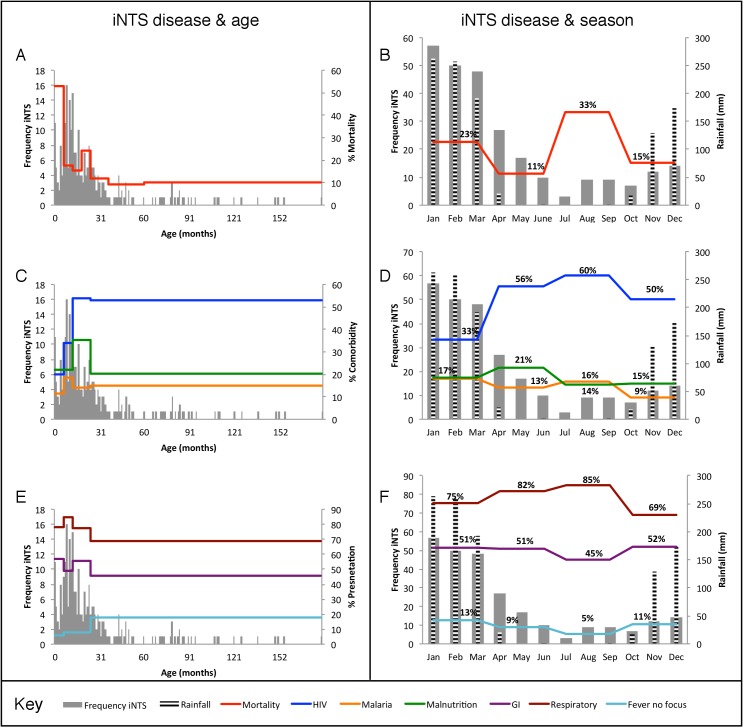
Variability in outcome, co-morbidity and clinical presentation of invasive Salmonella disease in Malawian children with age and season of presentation.Graphs indicate variation in mortality (A and B), co-morbidity (C and D) and clinical presentation (E and F) with age and month of the year. Each plot is overlaid on a histogram of the frequency of iNTS disease presentation with age (A, C and E) or bar-charts indicating monthly frequency of iNTS disease and monthly rainfall (B, D and F).